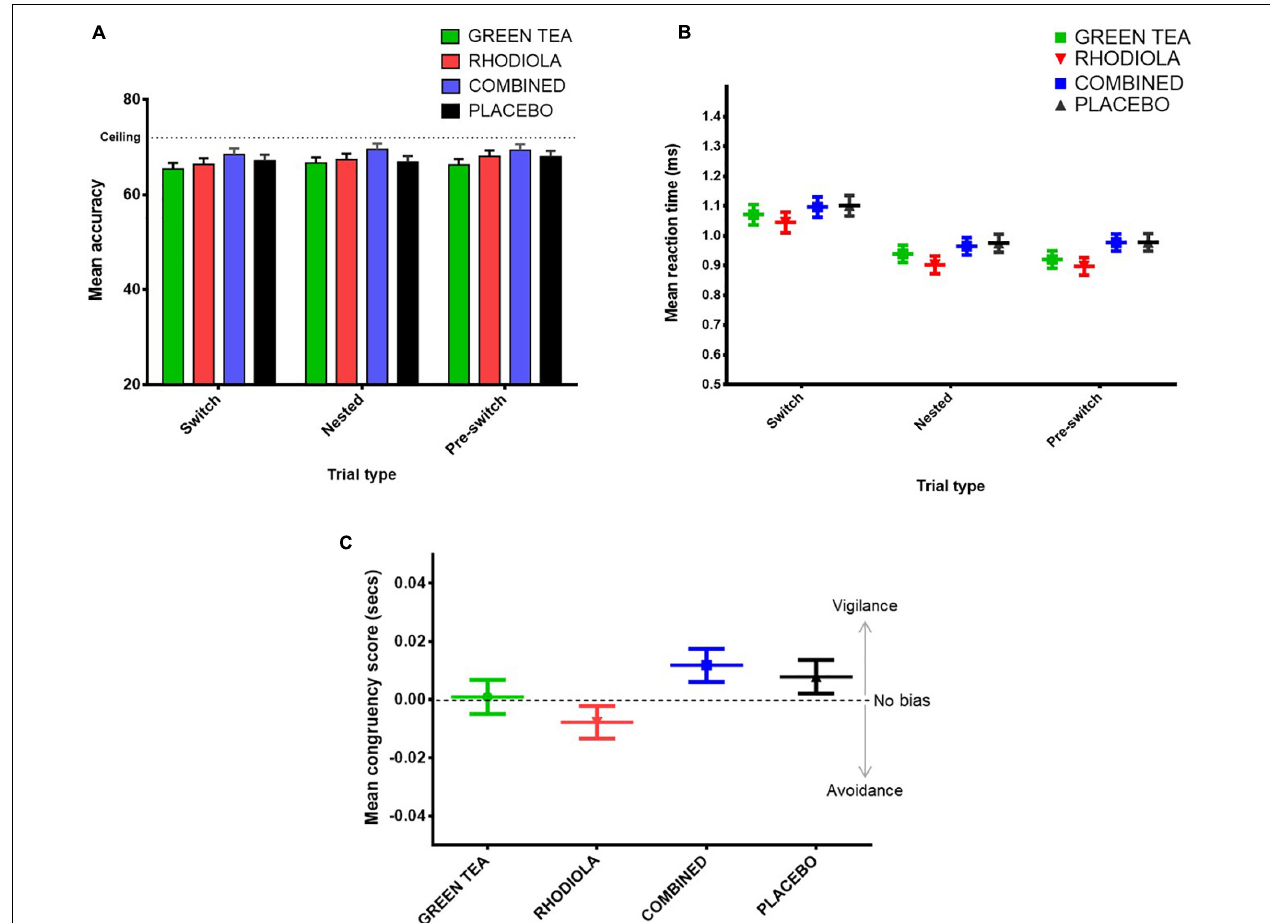
FIGURE 9 | Attention switching task (A) mean accuracy and (B) RT (ms) by trial type and treatment, and (C) attentional bias task attentional congruency score (incongruent trials RT – congruent trials RT) by